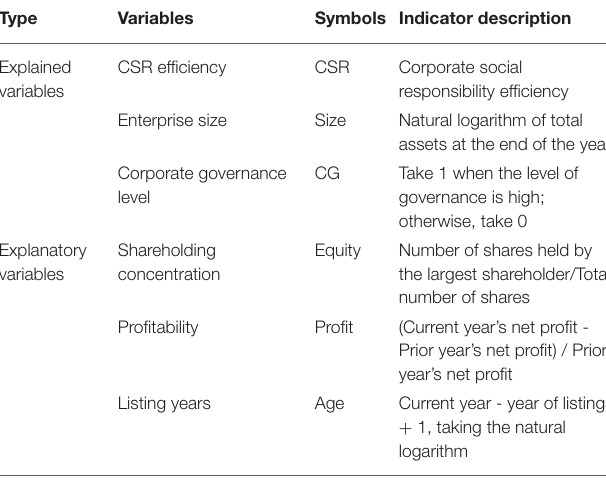
TABLE 7 | Factors influencing CSR